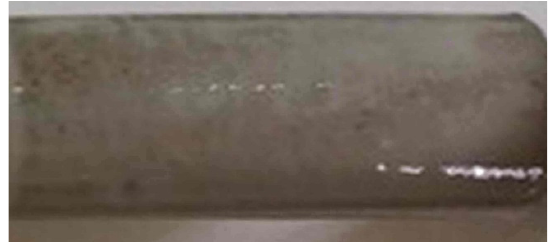
Figure 7. Wash contact time of 4 min.